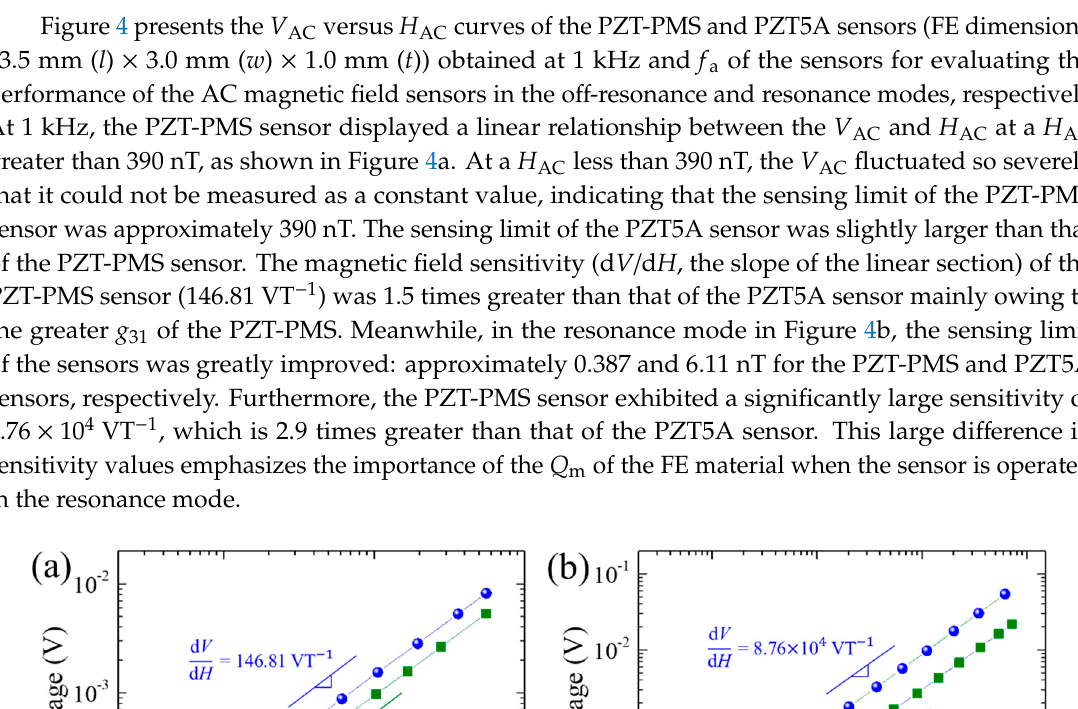
Figure 5. ( a ) Magnetoelectric voltage coefficient of PZT-PMS sensors with different lengths measured at 1 kHz as a function of H DC . ( b ) Magnetoelectric voltage coefficient spectra of the PZT-PMS sensors as a function of H AC frequency. (FE cross-sectional dimensions: 3.0 mm ( w ) × 1.0 mm ( t )).